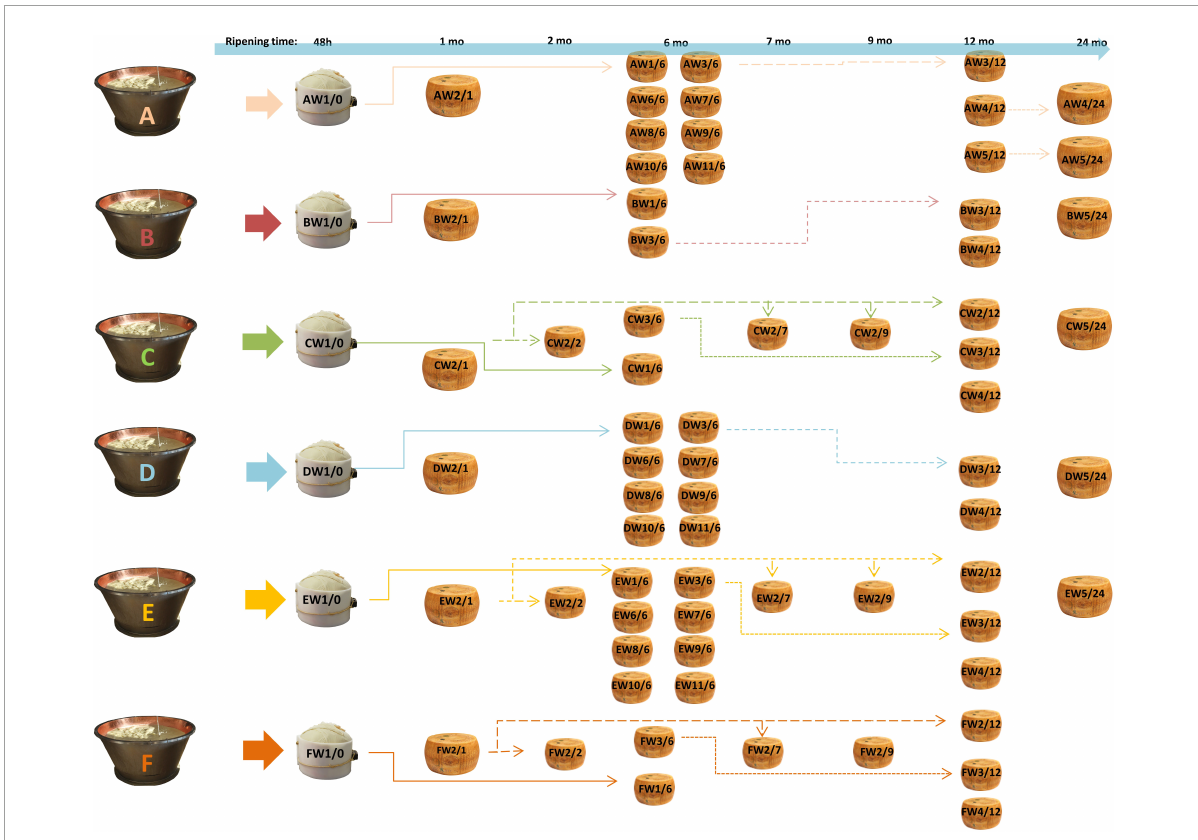
FIGURE1 Sampling scheme. For each dairy (A–F) , samples were taken from the same cheese-making lot (same wheel, W) at different ripening stages, and from different kinds of cheese-making lots (different wheels) at the same ripening stage. AW1/0 corresponds to dairy A, wheel 1, months of ripening 0, i.e., the curd after 48 h from cheese-making; AW1/6 is the same wheel sampled after 6 months. The same applies to other samples. Samples from the same cheese-making lot are connected by arrows. The time lime of ripening is also indicated at the top of the